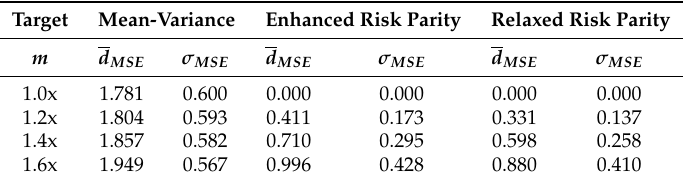
Table 8. Out-of-sample distance to risk